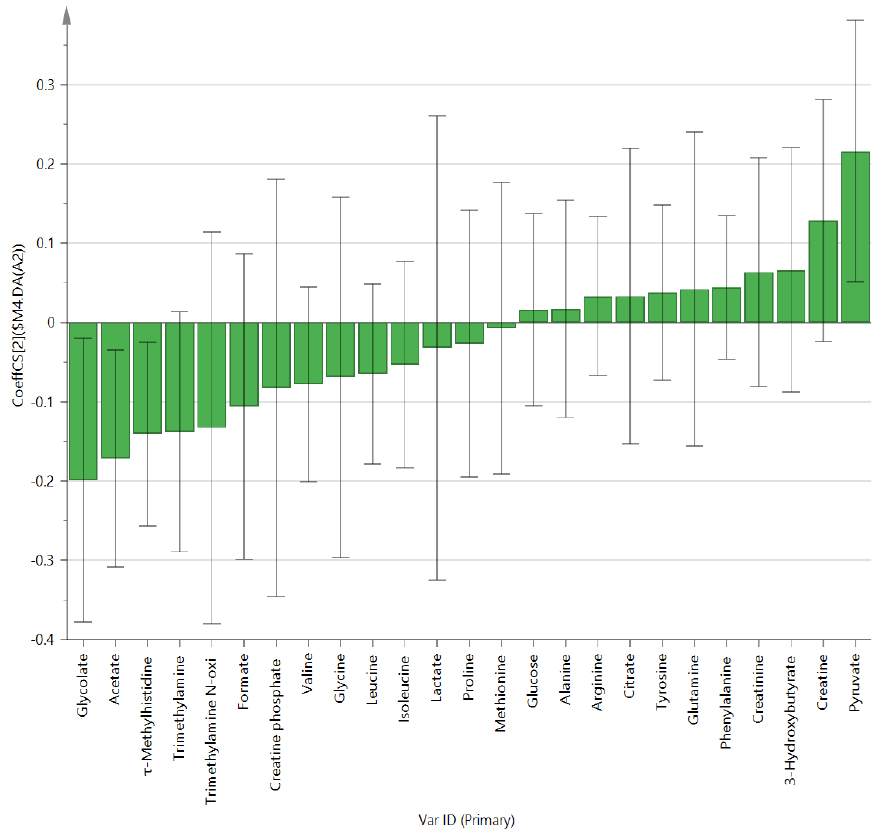
Figure 4. OPLS-DA coefficient plot of all metabolites in patients with ulcerative colitis.